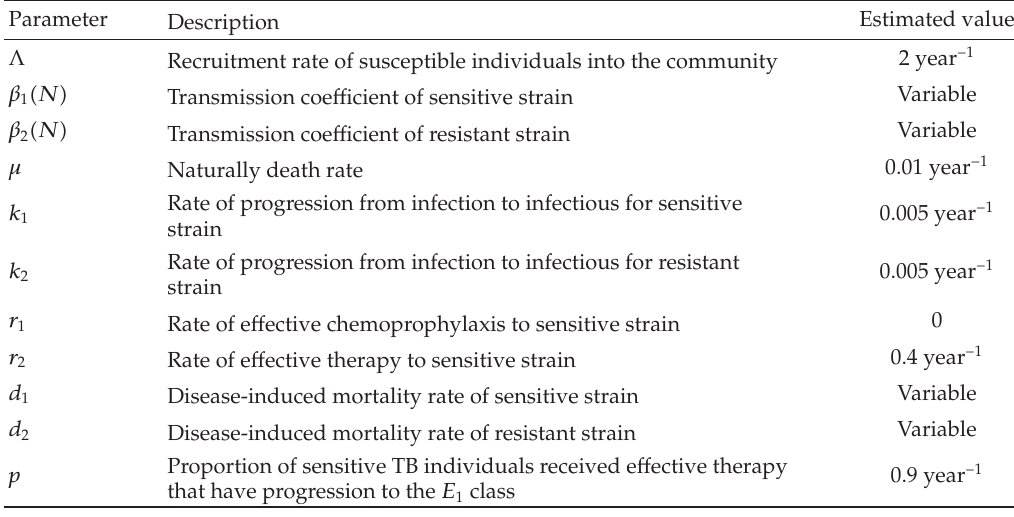
Table 1: Description and estimation of parameters.